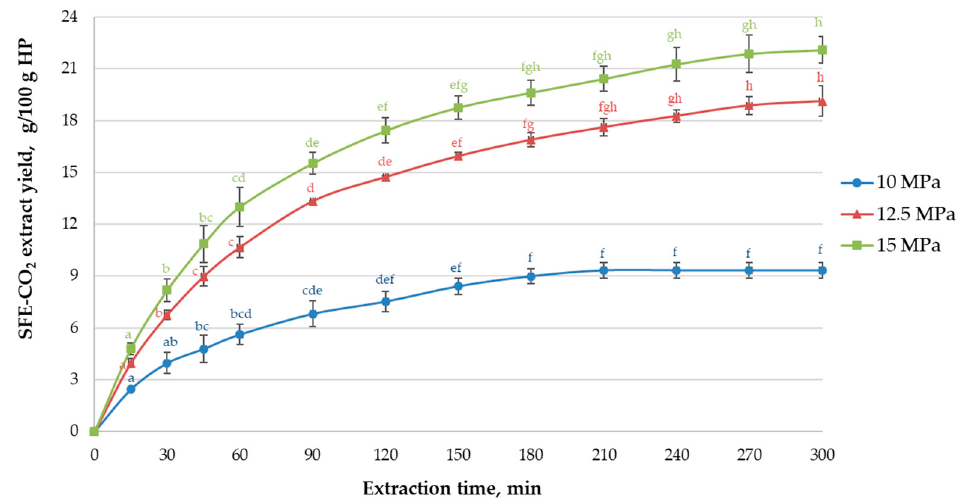
Figure 1. The influence of the extraction time on the Ella hop SFE-CO 2 extract yield (g/100 g pellets) at 10–15 MPa pressure at 40 ◦ C. SFE-CO 2 : supercritical carbon dioxide extraction. Different superscript letters indicate significant differences for each graph individually (one-way ANOVA and Tukey’s test p < 0.05). Table 1. Yields and TEAC ORAC of Ella hop SFE-CO 2 extracts obtained under the different experimental conditions.